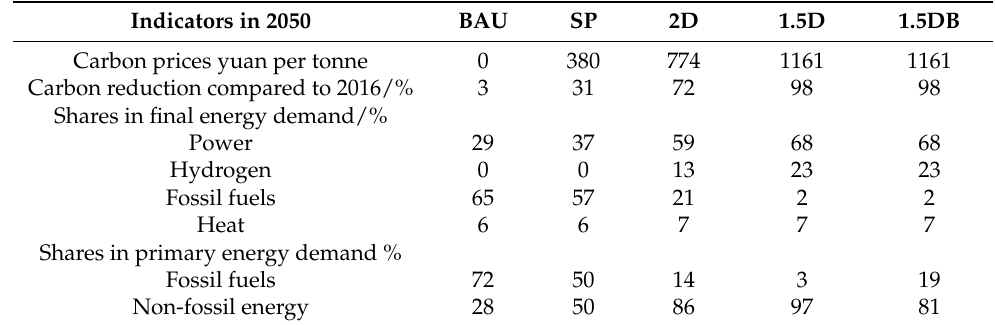
Table 2. Key indicators in 2050 in all scenarios.